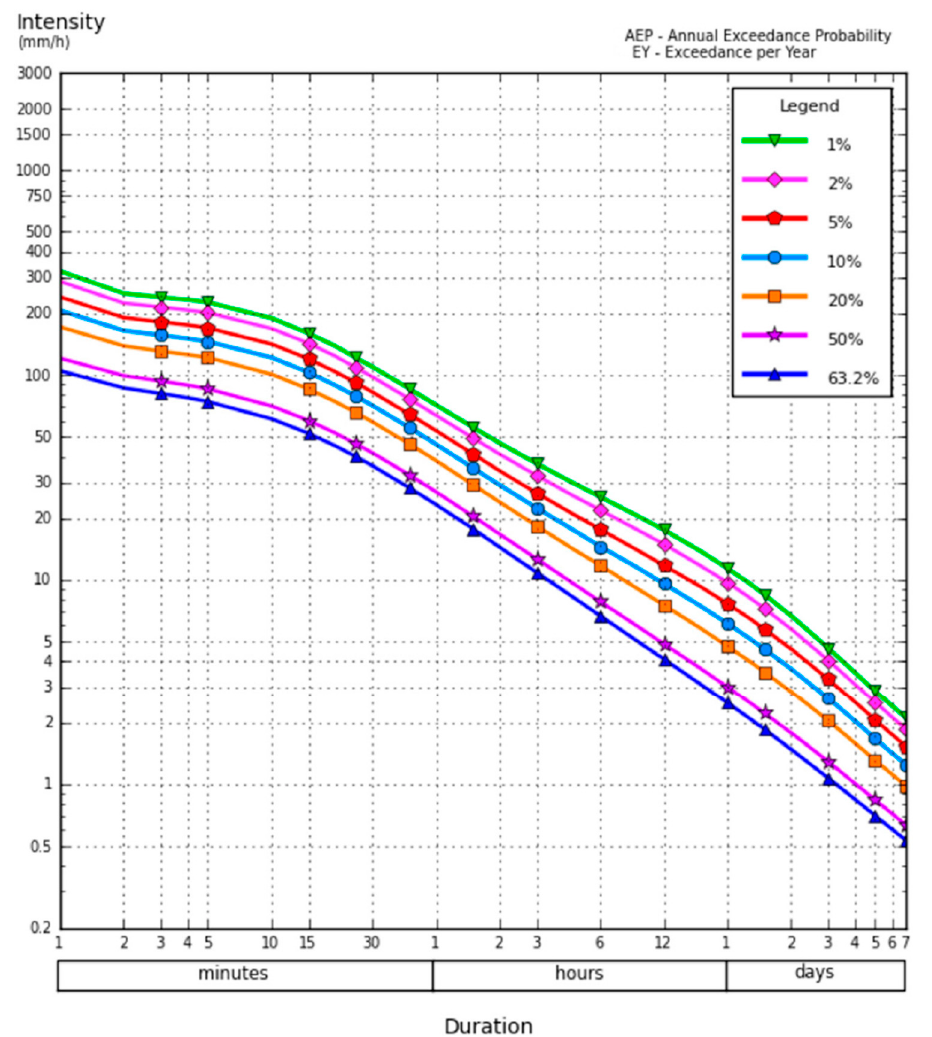
Figure 5. Single location IFD design rainfall plot (Catchment 1). Legend shows Annual Exceedance Probability (AEP) expressed as a percentage. Output from BOM Design Rainfall Data System [60].